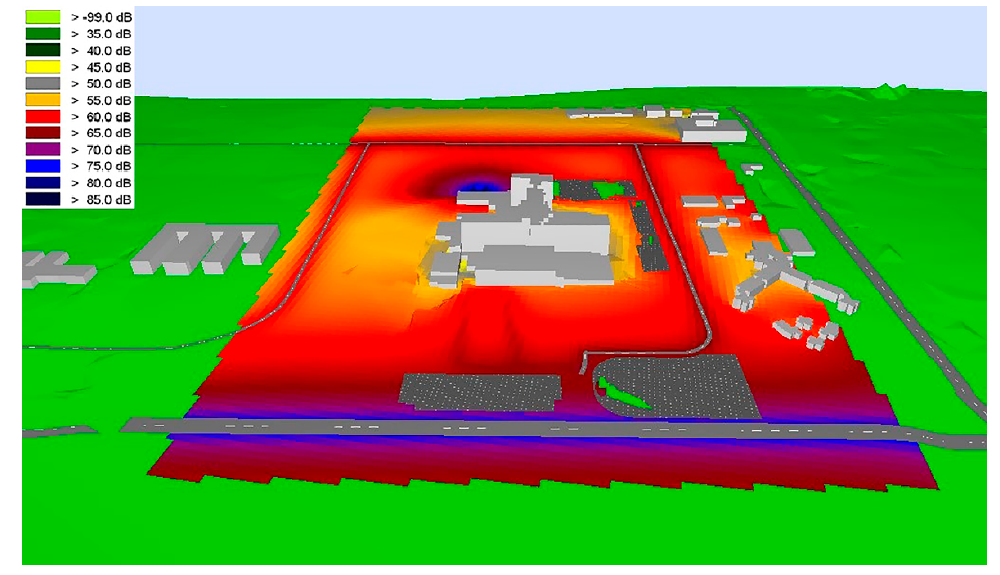
Figure 6. 3D view of the results of the noise propagation model at 4 m.